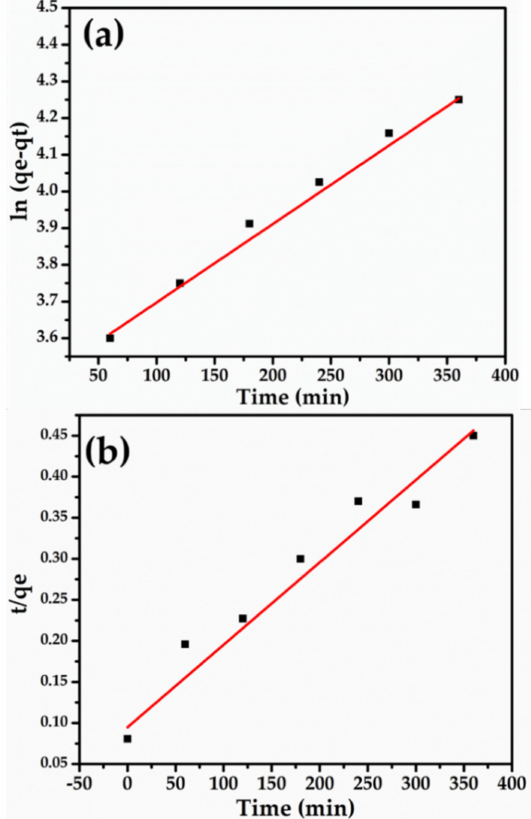
Figure 7. Data fitting in ( a ) pseudo first order and ( b ) pseudo-second-order kinetic